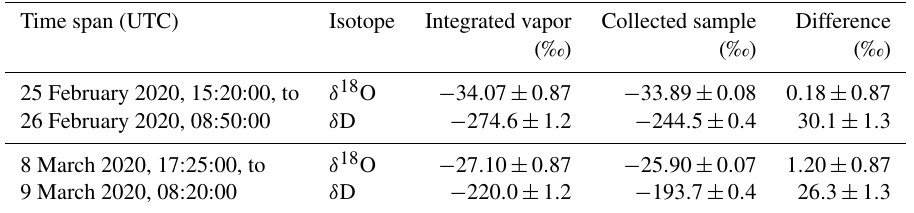
Table 4. δ 18 O and δ D measurements for two time periods, as observed by the CRDS analyzer (integrated vapor) and as collected by the cold trap (collected sample), alongside the differences